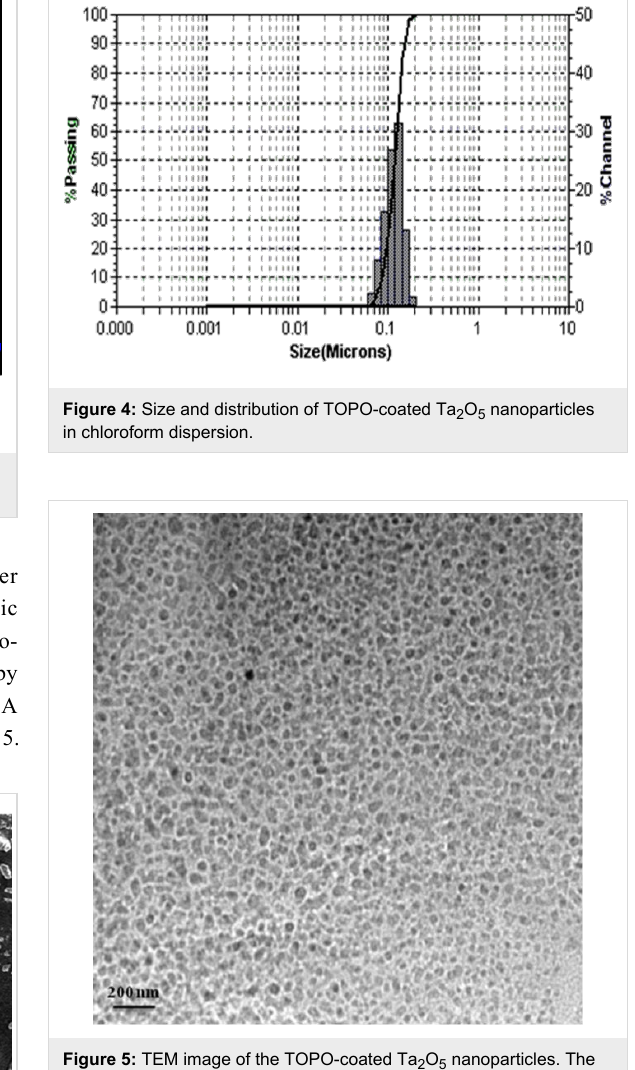
α -Al 2 O 3 as the reference. Figure 6 shows the TG/DTA/DSC curves obtained from the dried gel of Ta 2 O 5 . The TGA graph shows a weight loss up to a temperature of 200 °C that is essen- tially attributed to dehydration. The decomposition of organic substances at 200–400 °C is caused by the decomposition of organic species inside the mesopores of the sample. Further the weight loss in the temperature range of 400–650 °C is due to a phase transition. An exothermic peak centered at 386.7 °C in the DTA curve supports the statements above. The observation is also supported by the DSC